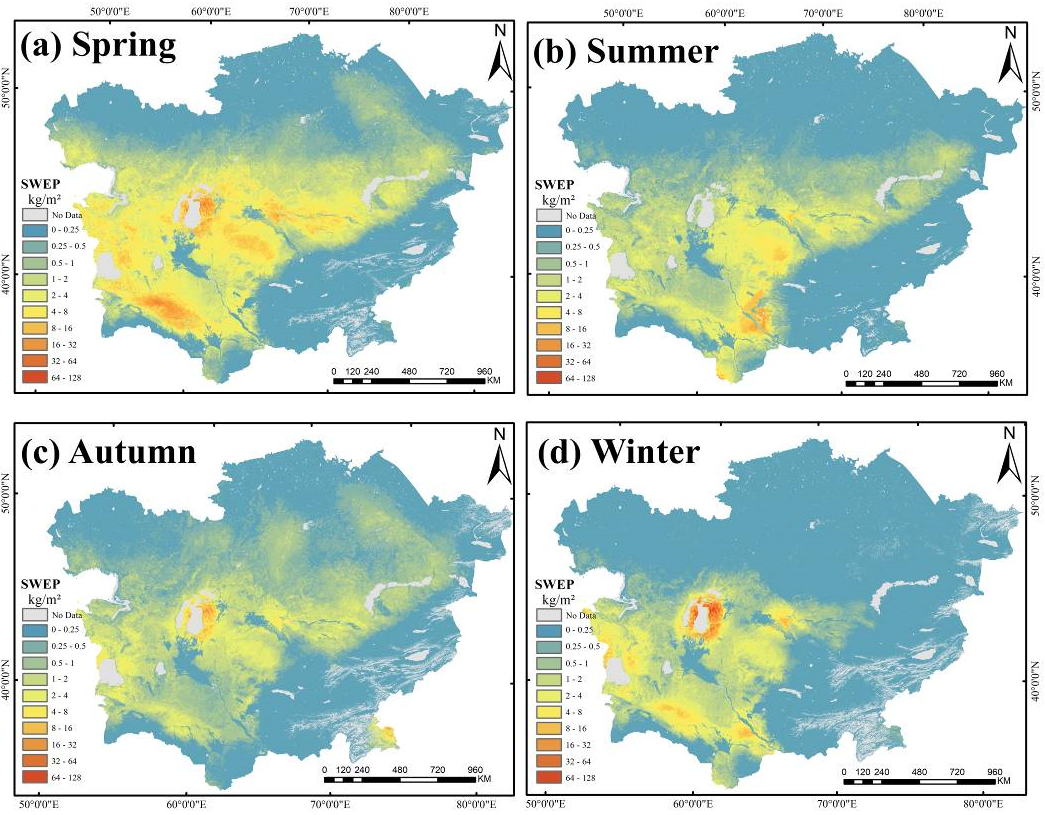
Figure 6. The seasonal variation of SWEP in ( a ) spring (Mar., Apr., May), ( b ) summer (Jun., Jul., Aug.), ( c ) autumn (Sept., Oct., Nov.), and ( d ) winter (Dec., Jan., Feb.) during the period of 2000–2019. Remote Sens. 2020 , 12 , x FOR PEER REVIEW